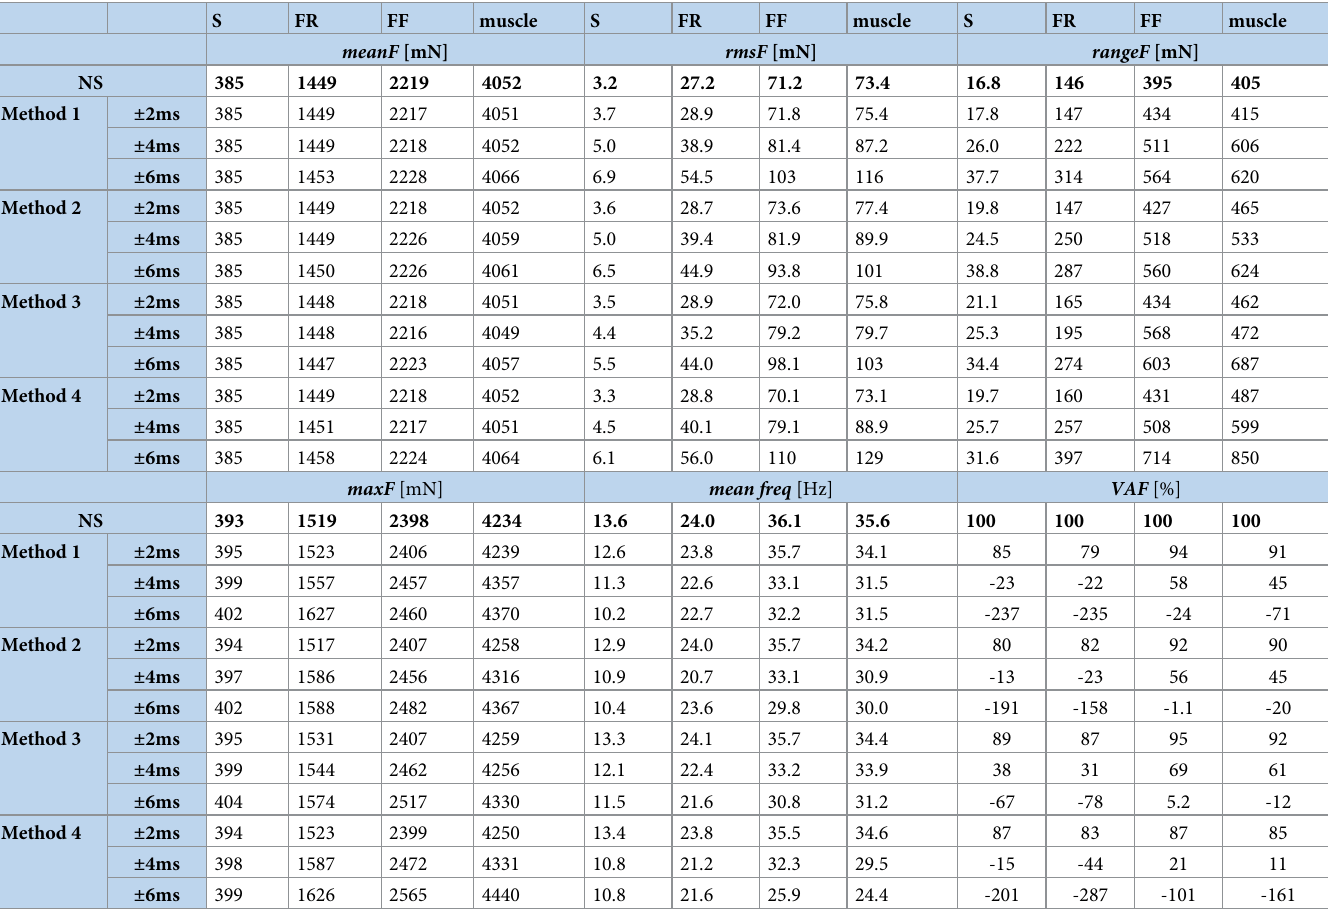
Table 3. Estimation of the six force parameters meanF , rmsF , rangeF , maxF , meanfreq and VAF of different physiologicl types of MUs (S, FR, and FF) and the whole muscle, produced by the NS model and four methods for synchronization (Methods 1–4), within three time windows ( ± 2, ± 4, and ± 6